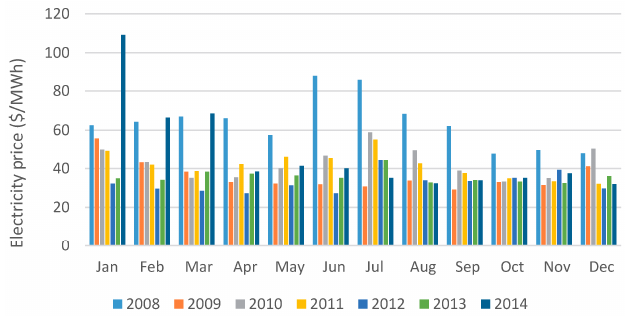
Figure 8. Monthly-based PJM average prices of electricity in RTM, considering the previous same nodes.